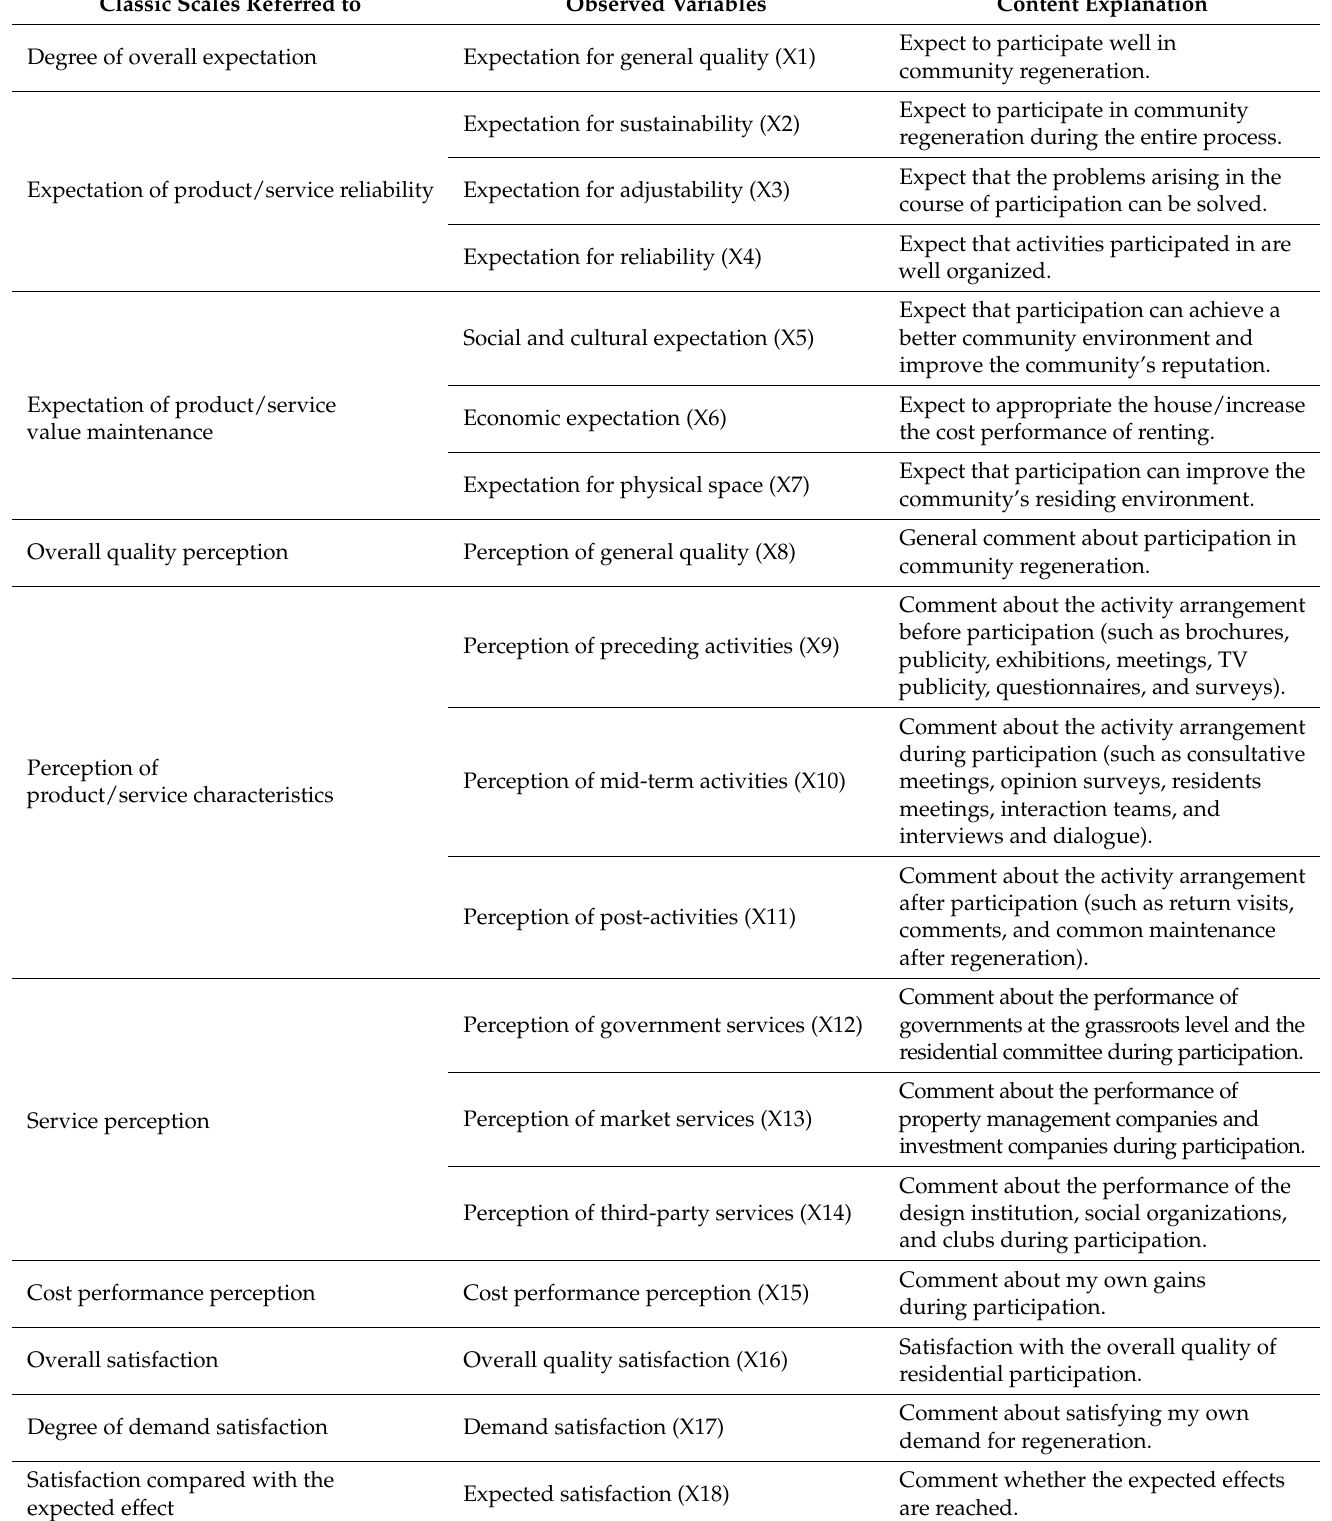
Table 3. Variables for evaluating the public participation